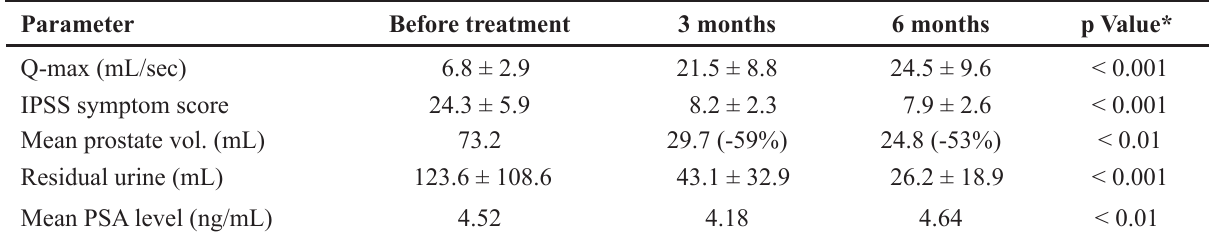
Table 4 – Comparative evaluation of all parameters before and after photoselective KTP laser prostatectomy.